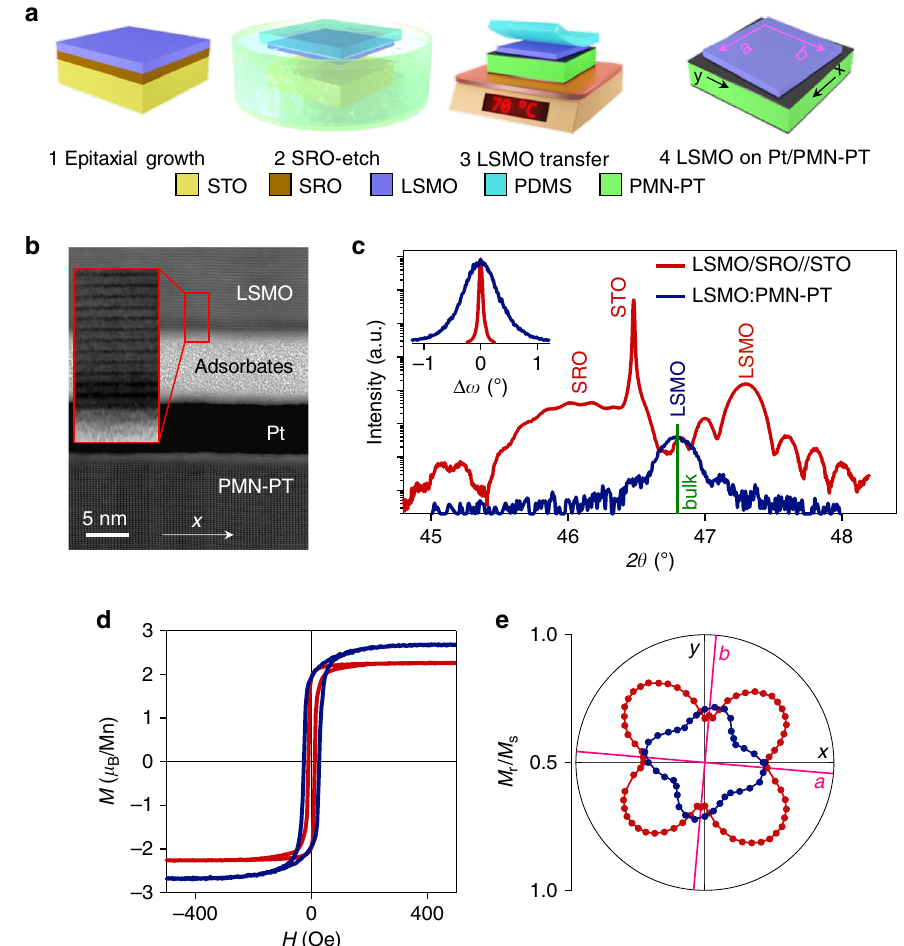
Fig. 1 Transfer of epitaxial LSMO (001) pc to platinized PMN-PT (011) pc . a The four-step transfer process in which we approximately aligned the edges of the LSMO fi lm (along a || [100] pc and b || [010] pc ) with the edges of the slightly larger PMN-PT substrate (along x || [100] pc and y || 01 (cid:1) 1 ½ (cid:2) cross-sectional STEM image of the interfacial region between LSMO and PMN-PT, looking down the 01 (cid:1) 1 ½ (cid:2) ×3.5 con fi rms in-plane LSMO misalignment. c – e Data for electrically virgin LSMO:PMN-PT (blue) and its LSMO/SRO//STO precursor (red). c XRD 2 θ – ω scans showing 002 pc re fl ections. The green vertical line corresponds to the expected 002 pc re fl ection for bulk LSMO with pseudocubic lattice parameter 60 3.881 Å. Inset: 002 pc rocking curves for LSMO. d Magnetization M versus collinear applied fi eld H for one of the two easy axes. e Polar plot of in-plane loop squareness M r / M s , where M r denotes remanent magnetization and M s denotes saturation magnetization. Data in b for sample C. Data in c – e for sample A and its precursor. All data were obtained at room temperature. Source data are provided as a Source Data fi